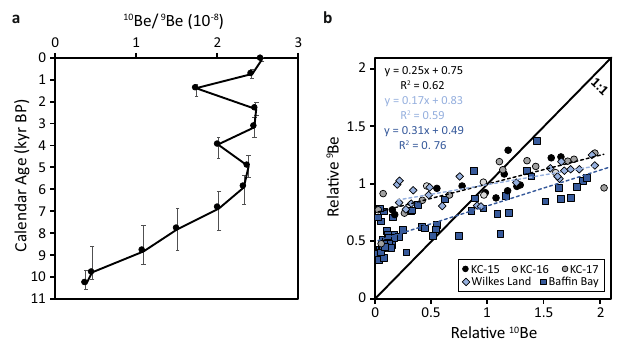
Fig. 3 Ice-shelf history of the CIS for the Holocene. The 10 Be/ 9 Be ratios ( a ) and relative 10 Be vs. 9 Be relationship ( b ) in OSO-0910 Kasten core KC- 15. Error bars represent 2 σ con fi dence intervals (Fig. S1). Relative Be isotope values from offshore Wilkes Land 37 and Baf fi n Bay 36 are presented using light blue diamonds and dark blue squares, respectively. The dashed black line, light blue line, and dark blue line represent the relationship for samples from this study, Wilkes Land 37 , and Baf fi n Bay 36 , respectively.